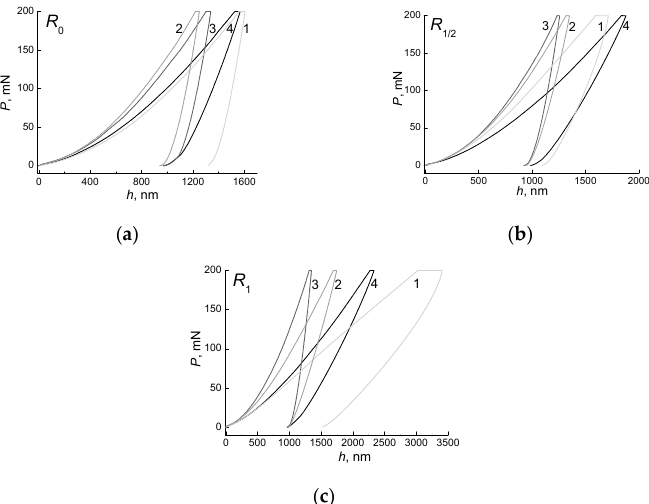
Figure 4. Dependences between load P applied to the Berkovich indenter and the indentation depth h for the alloys (1) Ti–1.98 wt.% Fe annealed at 470 °C, (2) Ti–2.04 wt.% Fe annealed at 470°, (3) Ti– 2.36 wt.% Fe annealed at 615 °C, (4) Ti–3.93 wt.% Fe annealed at 615 °C. After preliminary annealing, the samples were subjected to HPT (7 GPa, 1 rpm, 5 rot). The P ( h ) dependences were measured ( a ) in the sample center R 0 ; ( b ) in the middle of the radius R 1/2 and ( c ) at the sample edge R 1 .